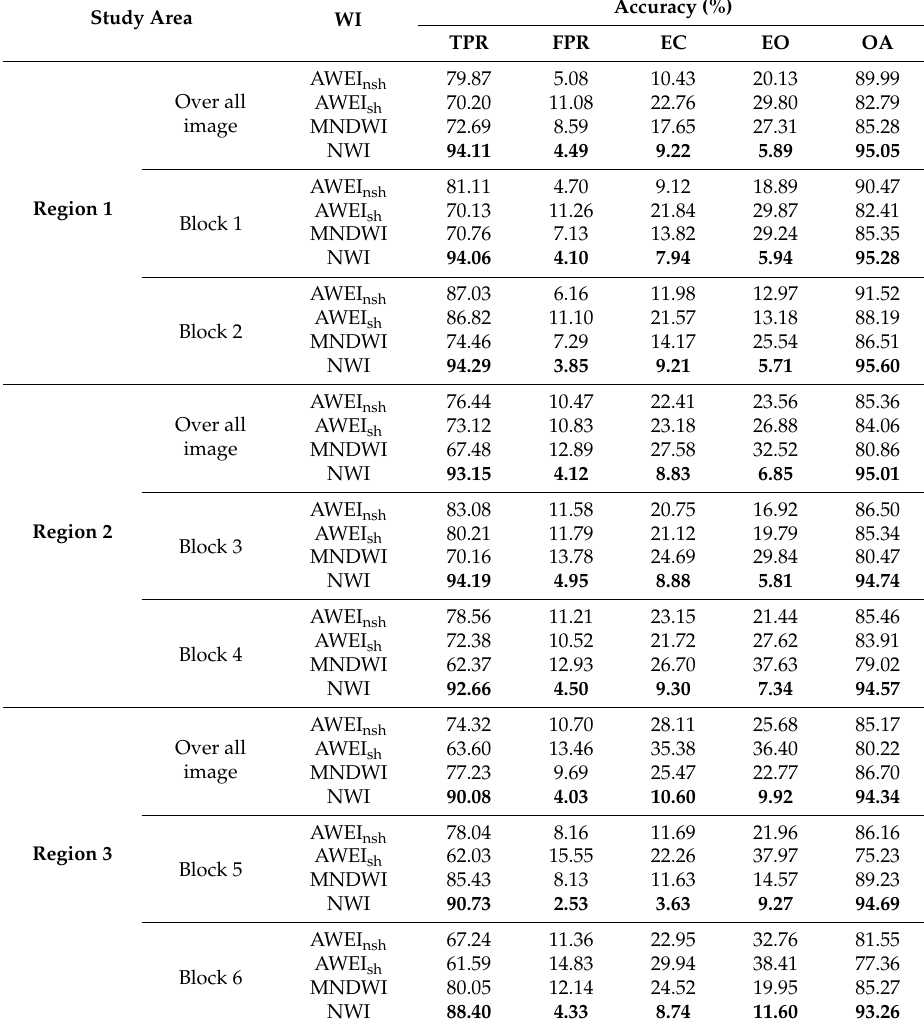
Table 2. Performance of the AMEW based on the AWEInsh, the AWEIsh, the MNDWI and the NWI. Accuracy (%) Study Area WI TPR FPR EC EO OA AWEI nsh Over all image